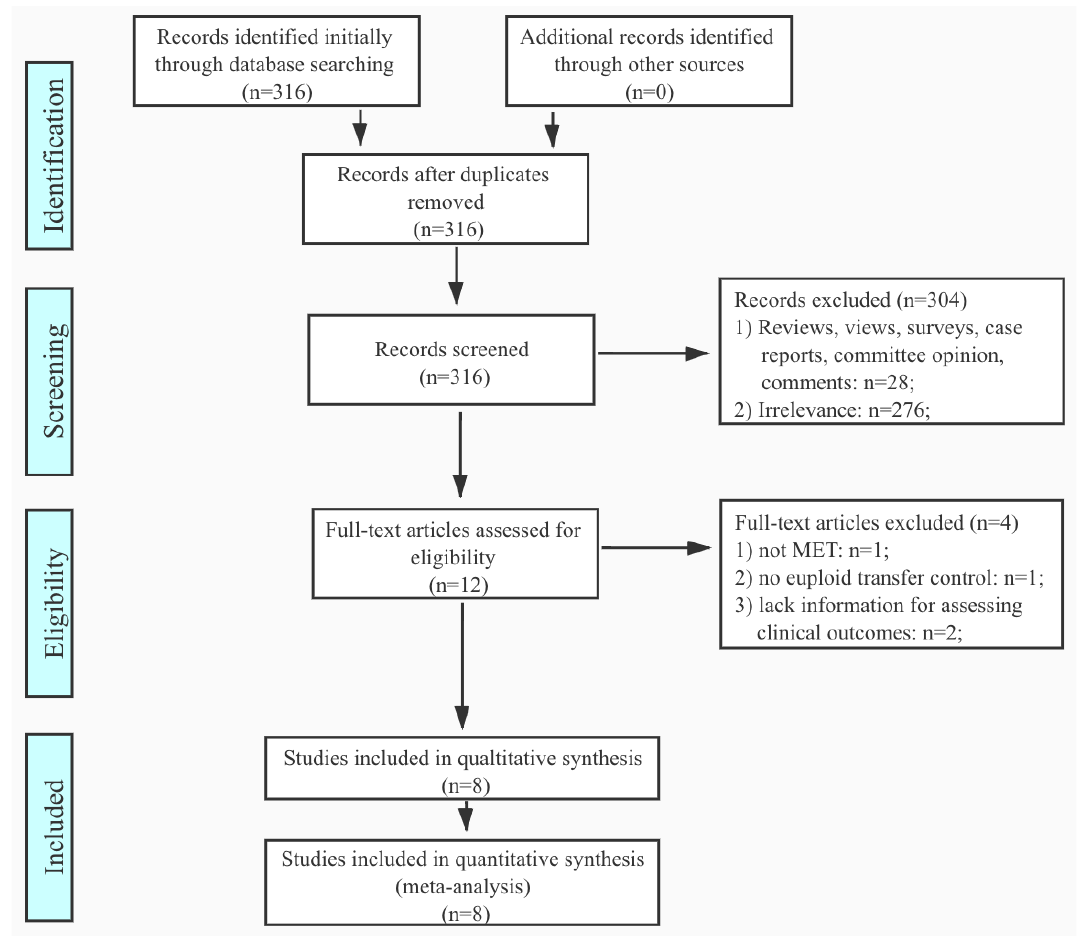
Figure 1. Preferred Reporting Items for Systematic Reviews and Meta-analyses (PRISMA) flow chart of literature search by the application of inclusion and exclusion criteria.